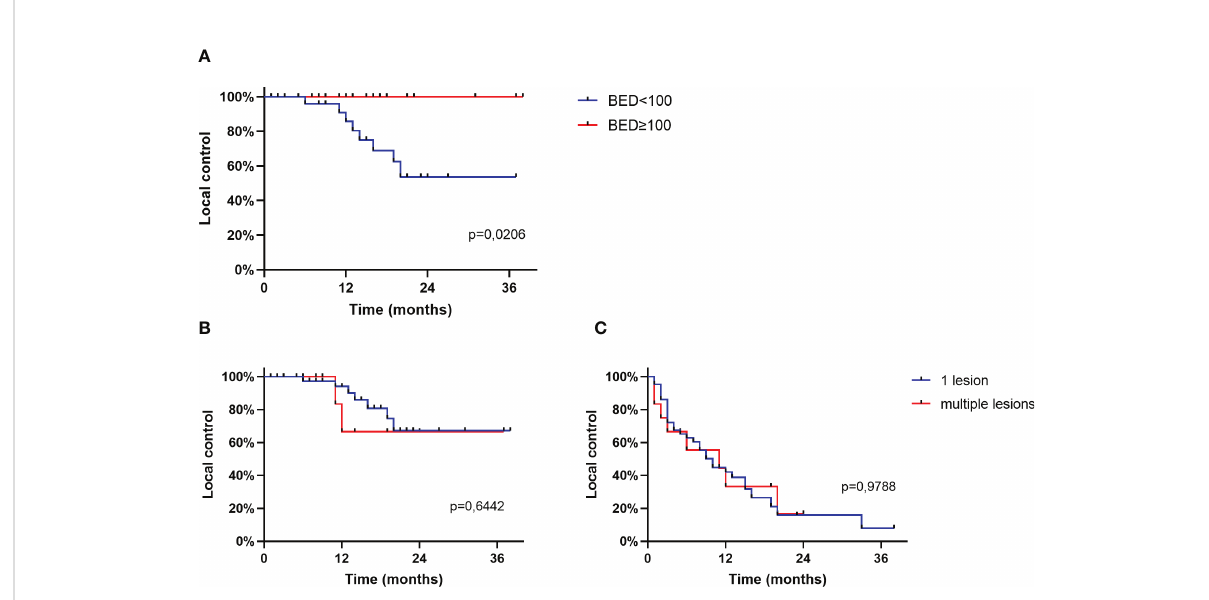
FIGURE 2 (A) : Local control of the irradiated liver lesion based on BED, (B) : Local control of the irradiated liver lesion based on number of treated lesions, (C) : Local control of the liver based on number of treated lesions.